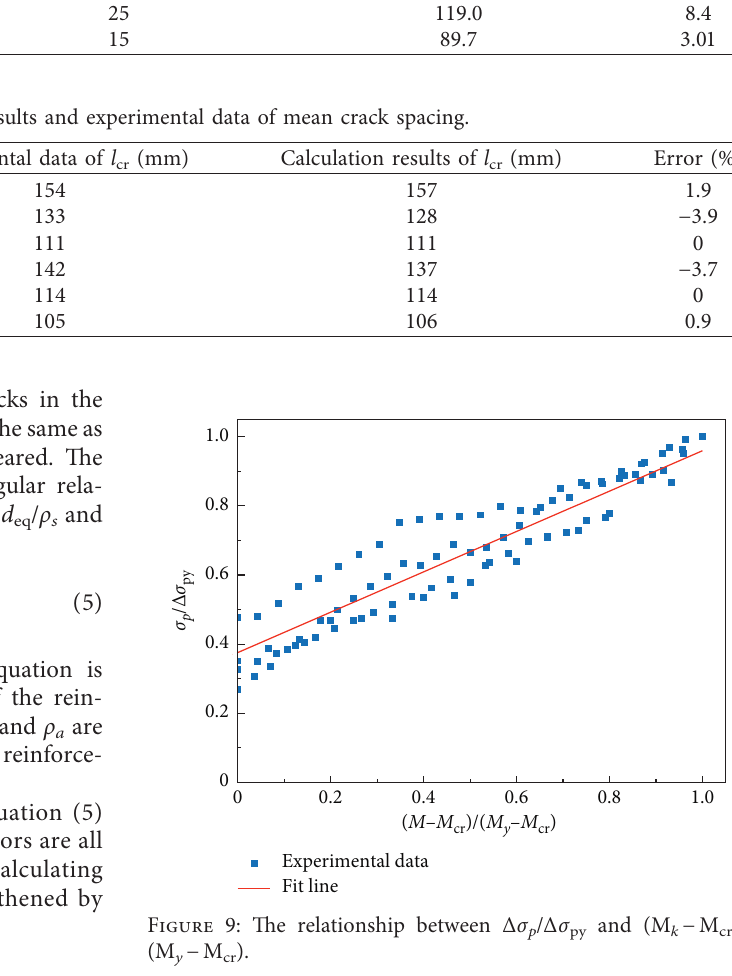
p / Δ σ py and (M k